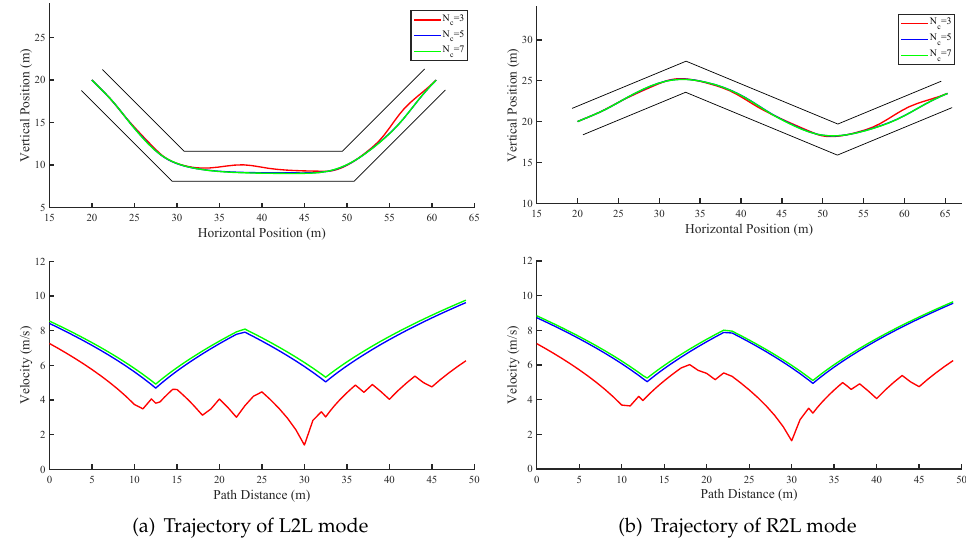
Figure 11. Trajectory generated by the SOTP method with different fitted circle numbers in the narrow corridor scene with the velocity curve. ( a ) the trajectory planned in the L2L mode. ( b ) the trajectory planned in the R2L